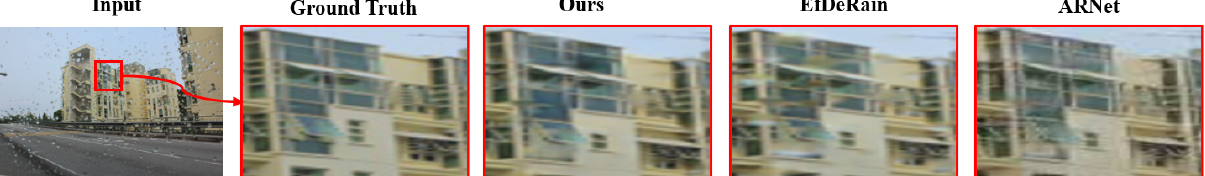
Figure 8. The visualisation results on Raindrops. Although ARNet [42] achieves the best performance in Table 4, the details and colour of the windows are restored best after the processing of